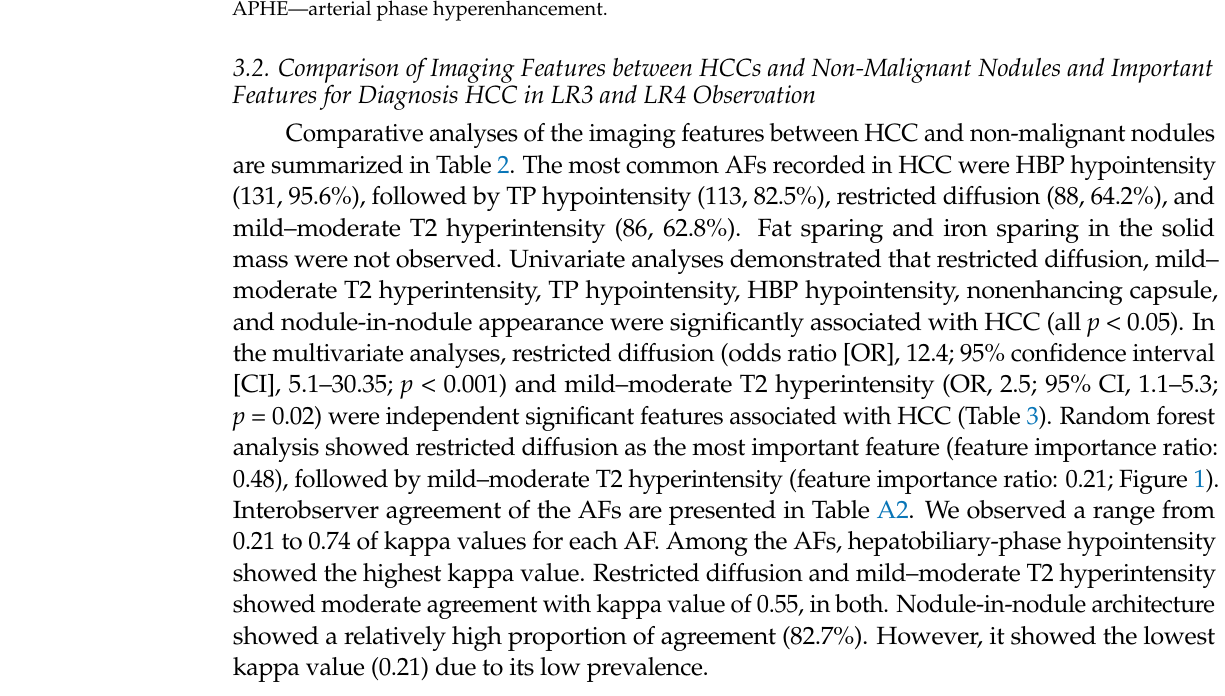
Table 2. Distribution of ancillary features favoring malignancy between HCC and non-malignant